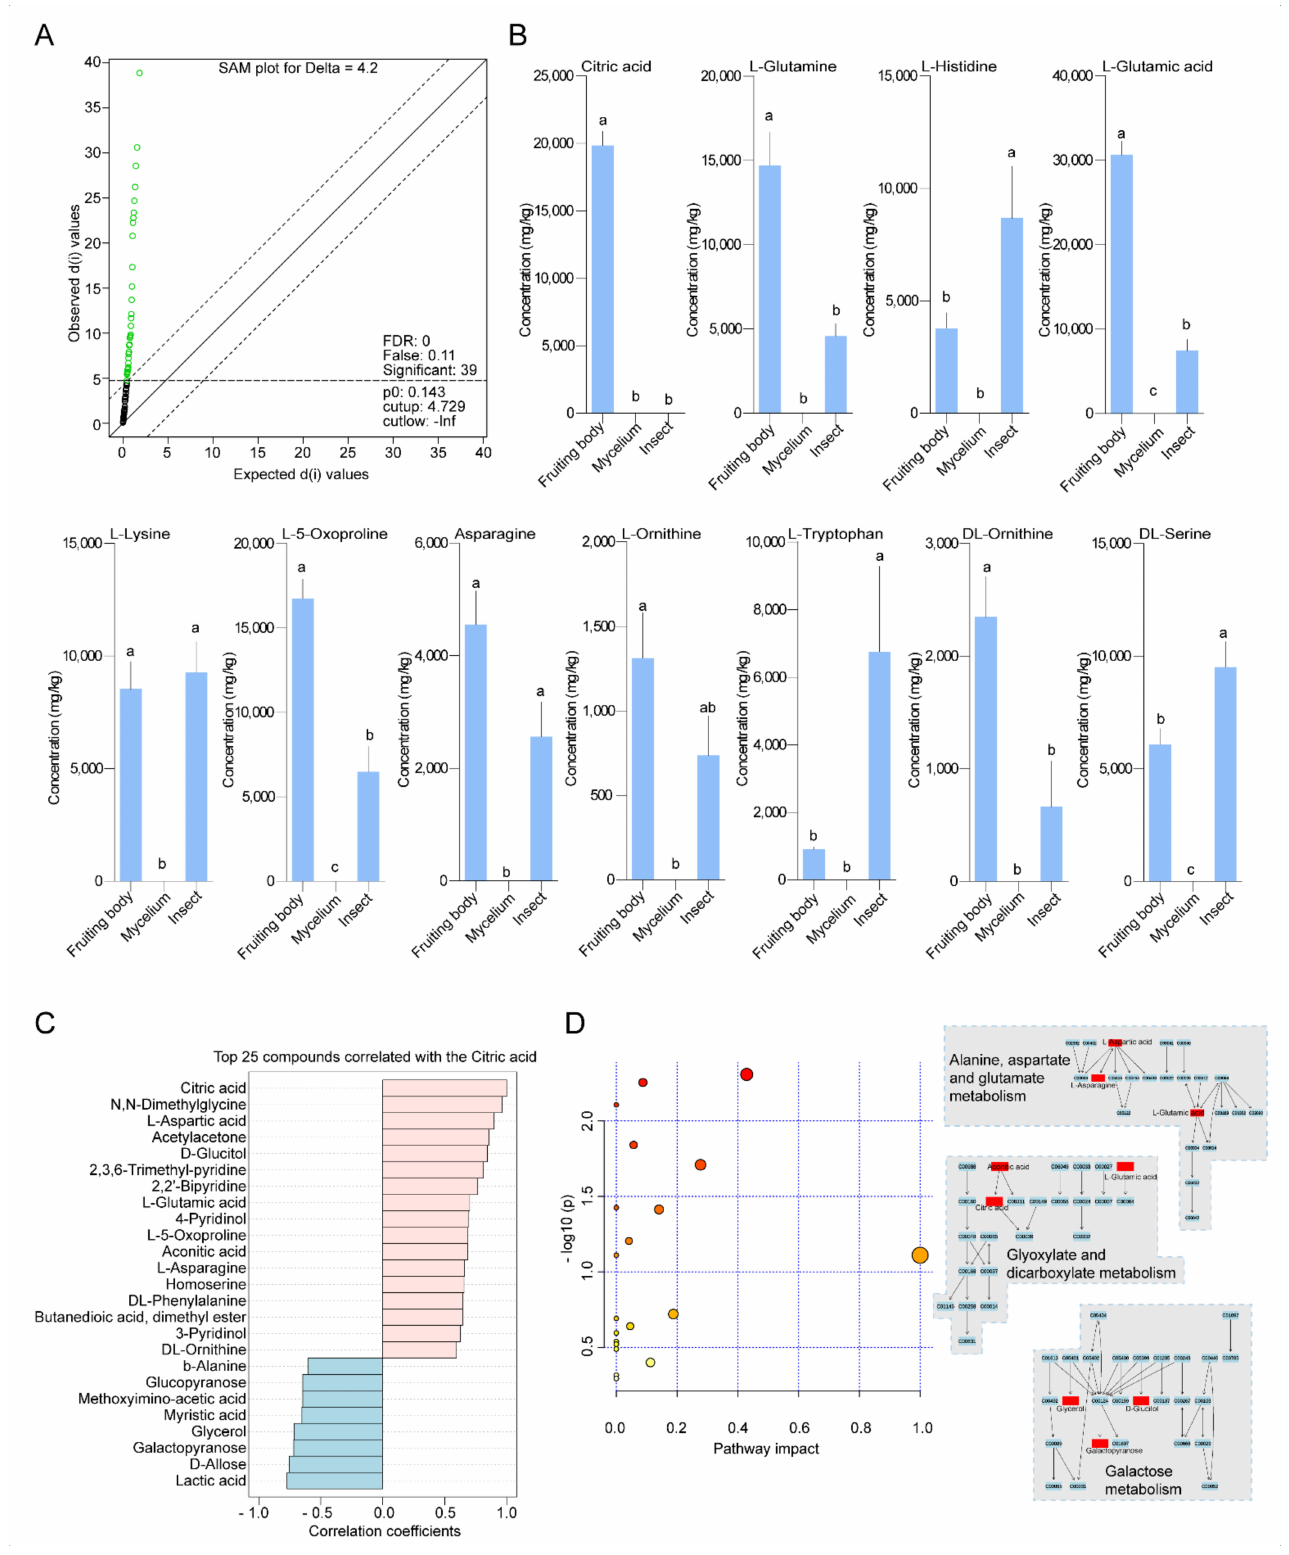
Figure 5. Featured fruiting body metabolites and pathway predictions. ( A ) Significance analysis of metabolomics (SAM) method addressing the false discovery rate (FDR) at ∆ = 4.2 to identify featured metabolites. List of featured metabolites was in Table S5. ( B ) Comparison of means in concentrations of the top 11 featured metabolites among groups. Lower-case letters indicate significant differences of concentrations in metabolites observed from groups of fruiting body, mycelium and insect ( GLM and Tukey HSD, p < 0.05). ( C ) Top 25 compounds correlated with the citric acid identified by